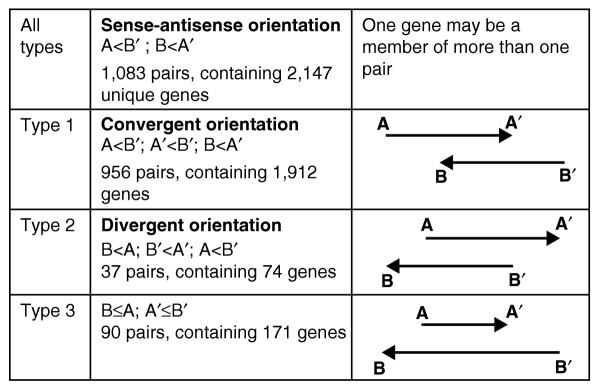
A comparison of the arrangements of overlapping gene pairs in Arabidopsis thaliana. A and A' label the start and end of the sense transcript, B' and B label the start and end of the antisense transcript. The total number of genes involved in group 1, 2 and 3 is 2,157, of which 2,147 are unique; the remaining 10 comprise four genes that are members of both group 1 and group 2 pairs, five genes that are members of both group 1 and group 3 pairs, and 1 gene that is a member of both a group 1 and group 3 pair.